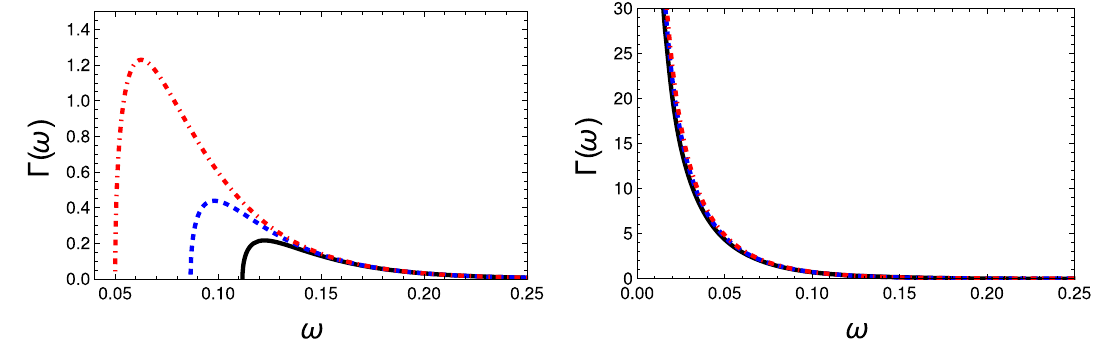
ξ = 0 . 12 (dotted-dashed red line). Right panel: Γ decay versus fre- quency for ξ = 0 . 15 (solid black line), ξ = 0 . 16 (dashed blue line), and ξ = 0 . 17 (dotted-dashed red line). In both figures we fix m = 1, r H = 2 and η = 0 . 25